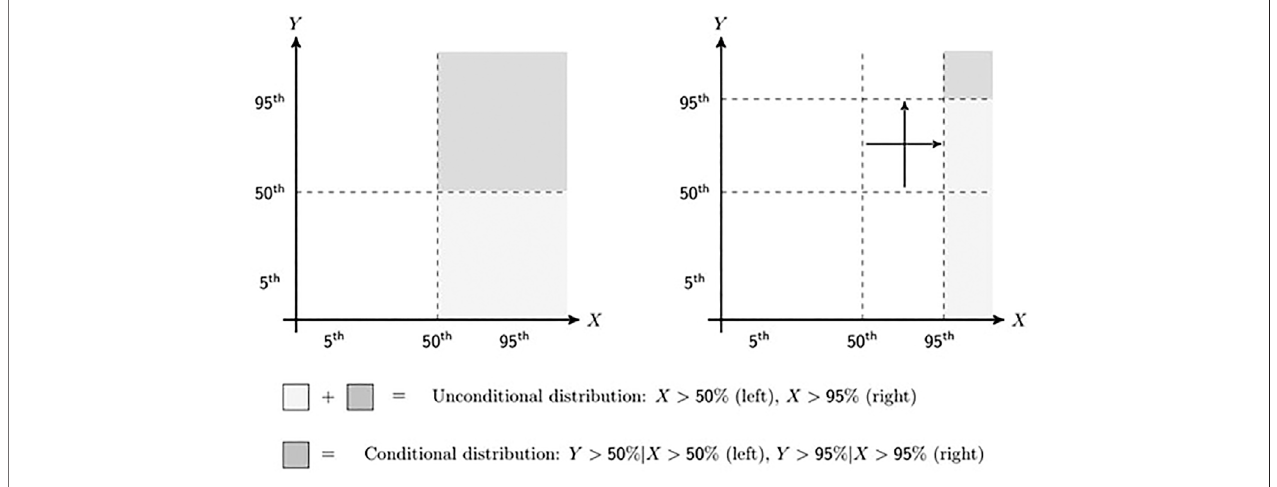
FIGURE 1 | Schematic representation of elicitation sequence with fi rst assessment on the left and last on the right.